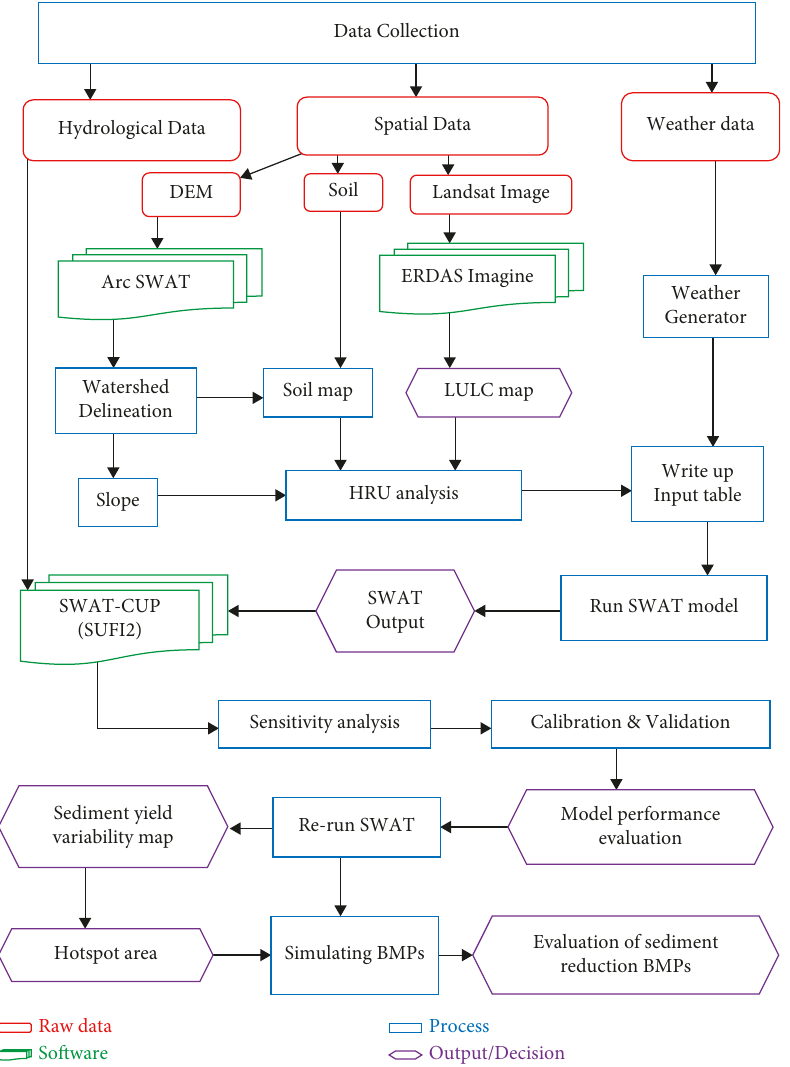
Figure 8: General workflow diagram for